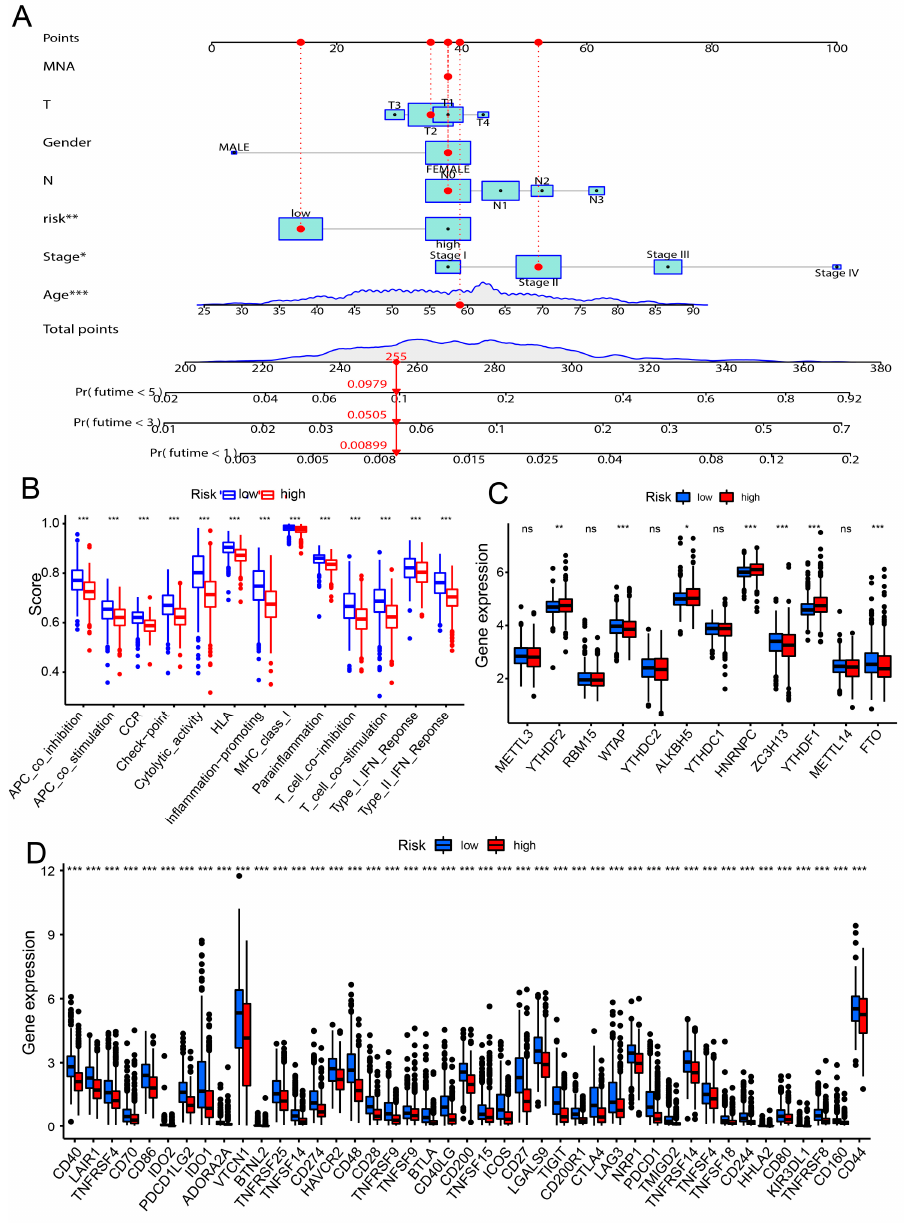
Figure 5. Correlation of the risk model and cancer immunity. ( A ) According to the risk model, prediction of the one-year, three-year and five-year overall survival of breast cancer patients